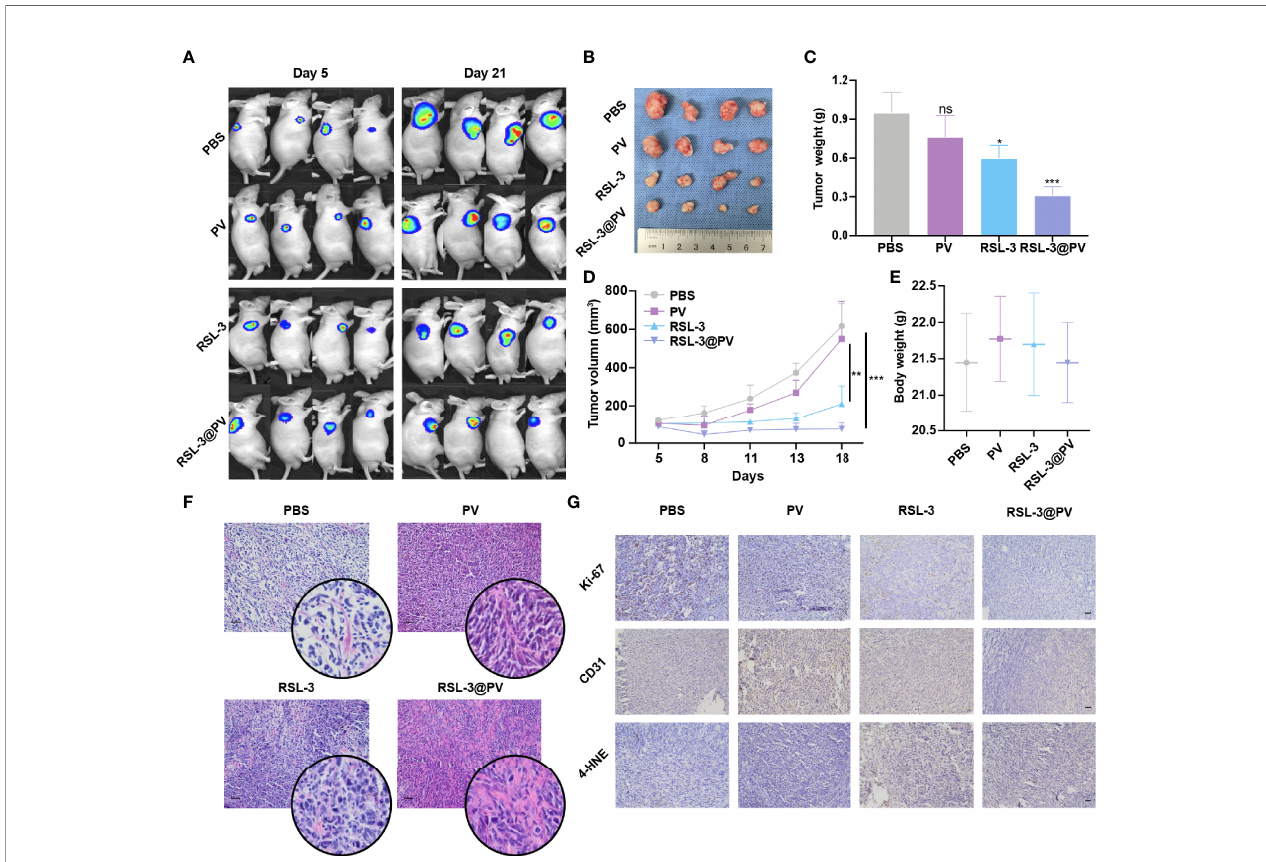
FIGURE 4 | Antitumor activity of RSL-3@PVs. (A) Fluorescence images of tumors at day 5 and day 21 after injection of the indicated formulations into PDAC xenograft nude mice (n = 4). (B) Representative images of tumors excised at the end of the experiment (n = 4). (C) The volumes of tumors collected at the end of treatment (n = 4). (D) Tumor growth curves of PDAC xenograft BALB/c nude mice treated with the indicated formulations (n = 4). (E) The body weights of mice measured at the end of treatment (n = 4). (F) H&E staining of the dissected tumor tissues in the indicated treatment group. Scale bars, 100 m m. (G) Ki-67, CD31 and 4-HNE staining of the dissected tumor tissues in the indicated treatment group. Scale bars, 100 m m. Error bars represent the mean ± s.d. Student ’ s t test or one- way ANOVA was used for comparison between two groups or among multiple groups, ns P > 0.05, *P < 0.05, **P < 0.01, and ***P <